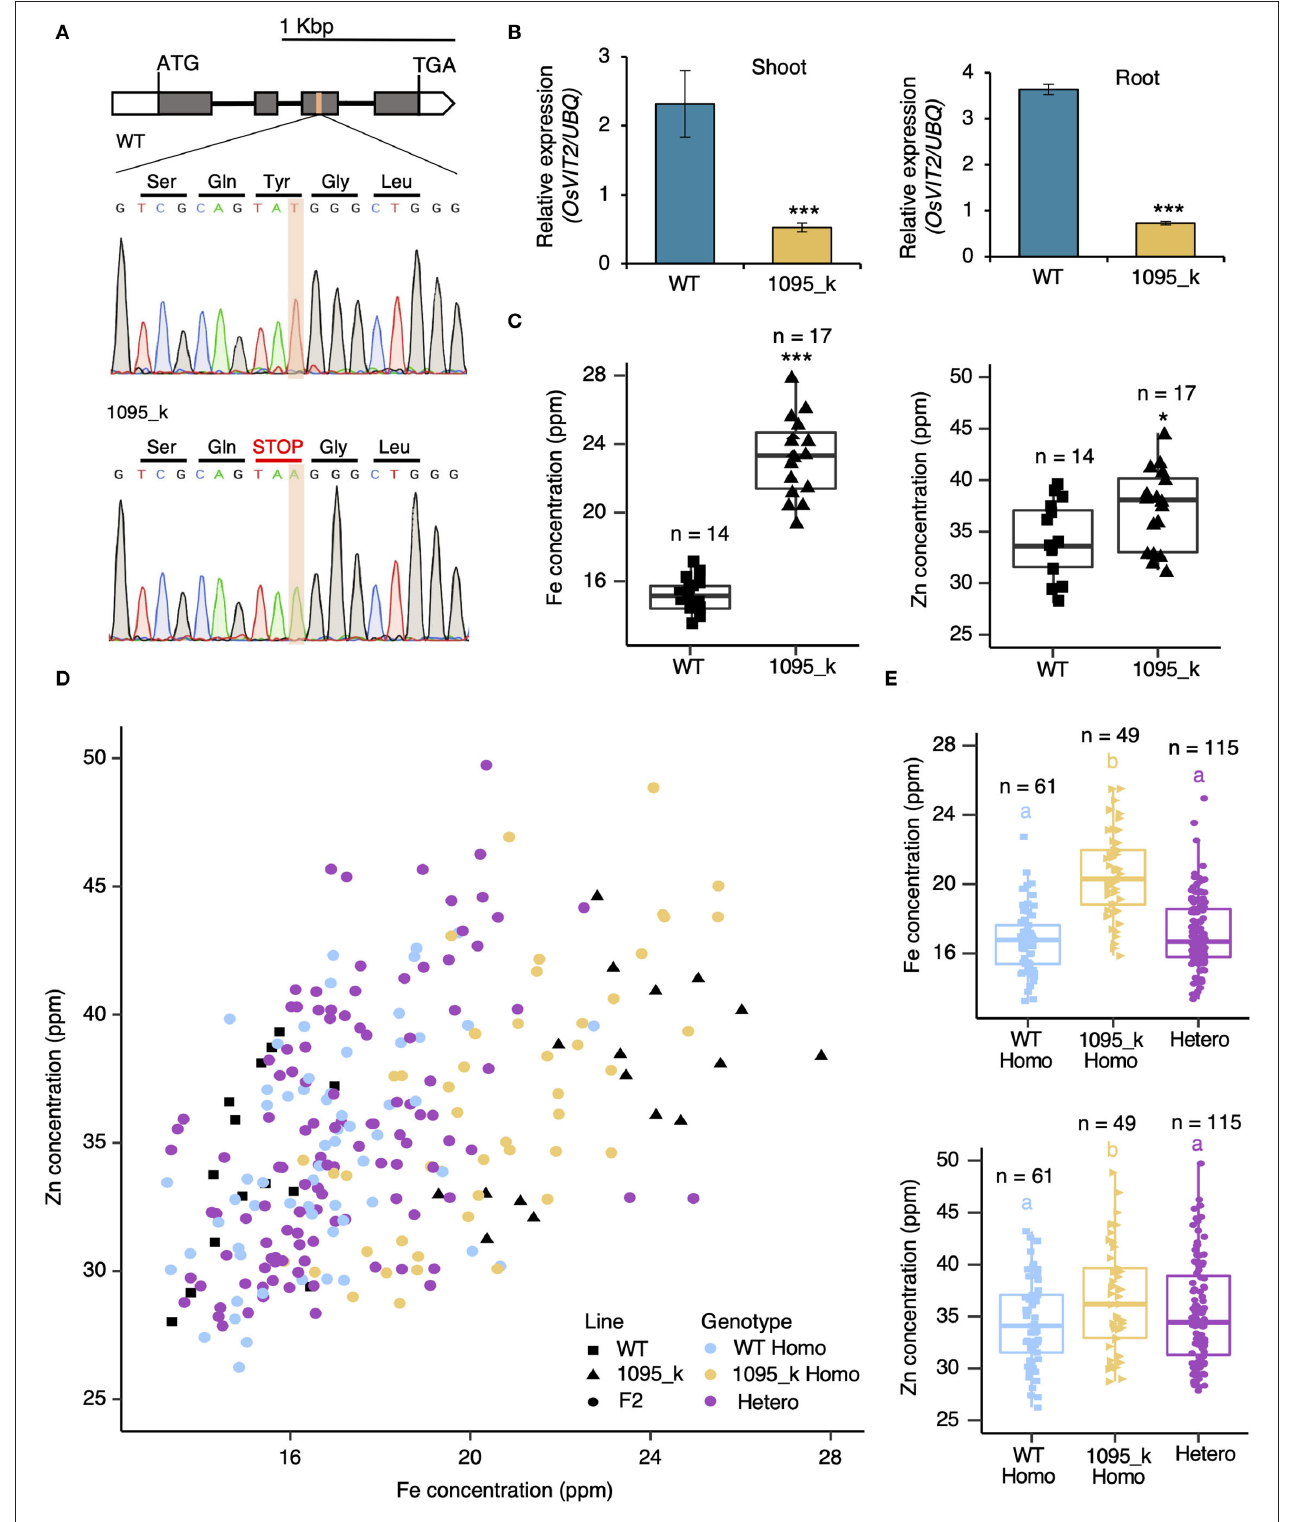
FIGURE 3 | The correlation between mutated OsVIT2 and high Fe phenotype. (A) Intron-exon structure of OsVIT2 with sequence alignment of WT and 1095_k (box and line are exon and intron, whereas white box and gray box represent UTR and CDS, respectively). Nucleotide changes are indicated by the red box in